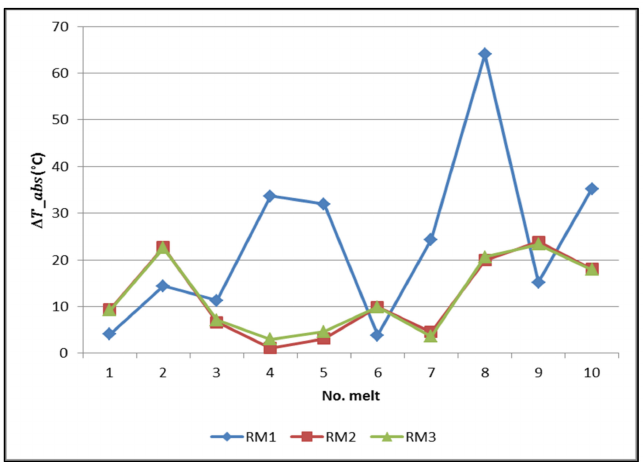
Figure 6. Absolute deviation of temperature for regression